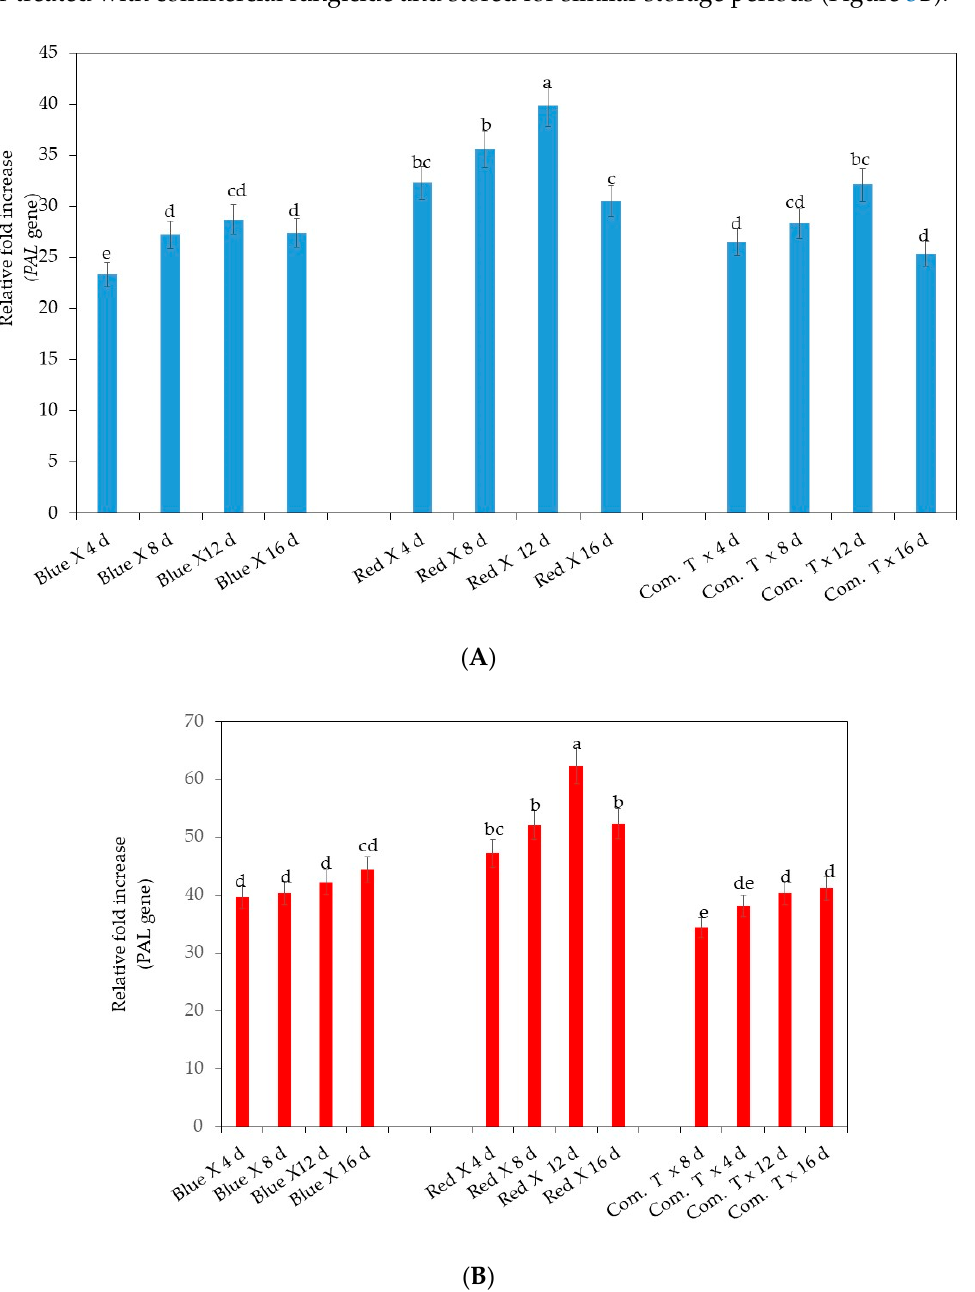
Figure 3. ( A ) Influence of LED light exposure on PAL (phenylalanine ammonia lyase gene expression) in avocado cultivar Fuerte. ( B ) Influence of LED light exposure on PAL (phenylalanine ammonia lyase gene expression) in avocado cultivar Hass. The exposure of the fruit to blue or red LED light was for 6 h per day during storage. Number of replicates per treatment n = 5. Mean values of bars marked by different letters were significantly different at p < 0.05, according to Fisher’s protected LSD test. Blue, blue LED light; Red, red LED light; Com. T, commercial treatment.